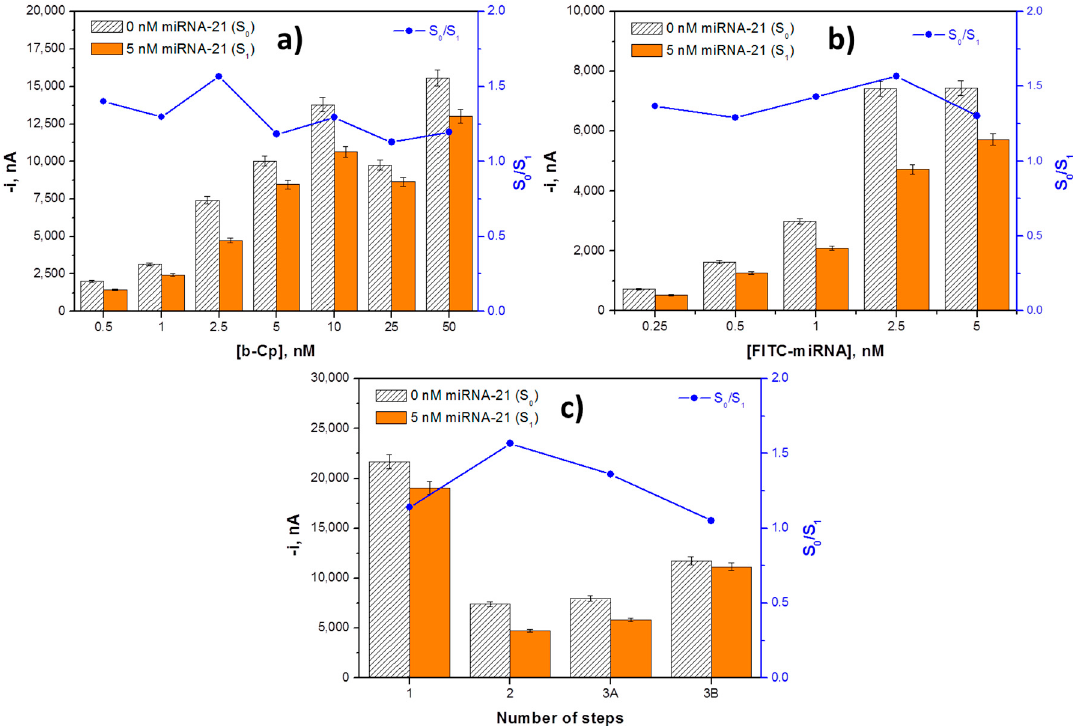
Figure 2. Dependence of the amperometric signals measured with the competitive DNA/RNA hybridization biosensor in the absence (S 0 ) and in the presence of 5.0 nM miRNA-21 (S 1 ), and the corresponding S 0 /S 1 ratio with the b-Cp ( a ) and FITC-miRNA ( b ) loadings and with the number of steps involved in the biosensor preparation ( c ). Error bars estimated as three times the standard deviation of three replicates.